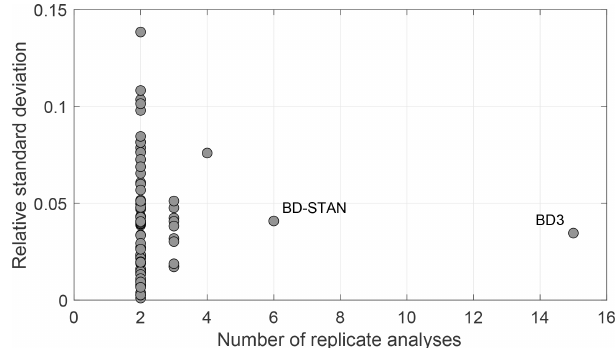
Figure 8. Relative standard deviation for analyses of replicate splits of 84 sediment samples that were analyzed more than once. Data have been corrected for current dependence